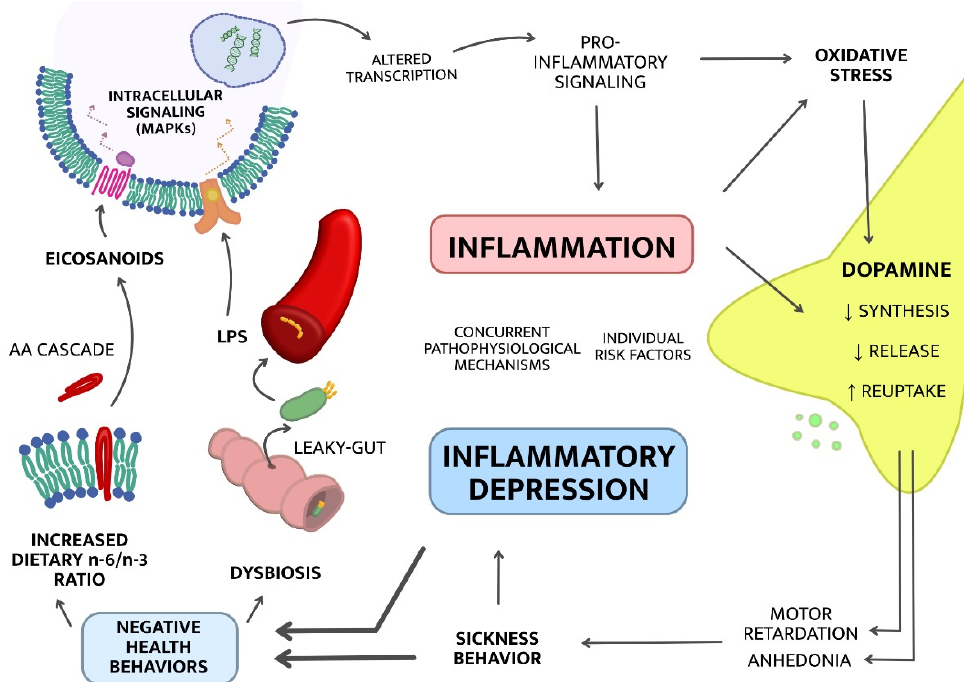
Figure 1. Hypothetical model of bidirectional interactions between systemic low-grade inflammation and depression. From bottom left: Negative health behaviors such as poor dietary habits, stress, and a sedentary lifestyle could trigger and/or enhance inflammatory responses. Below, we discuss two potential mechanisms mediating the effects of such behaviors on inflammation; increased dietary n-6/n-3 ratio and dysbiosis. Subsequent pro-inflammatory signaling may trigger oxidative stress and lead to alterations in dopamine release, reuptake and synthesis. This in turn may generate symptoms of psychomotor retardation and motivational anhedonia, further reinforcing a state of sickness behavior, and may induce, enhance, or maintain depression and more negative health behaviors. Abbreviations: omega-6 (n-6), omega-3 (n-3), arachidonic acid (AA), lipopolysaccharide (LPS), mitogen-activated protein kinases